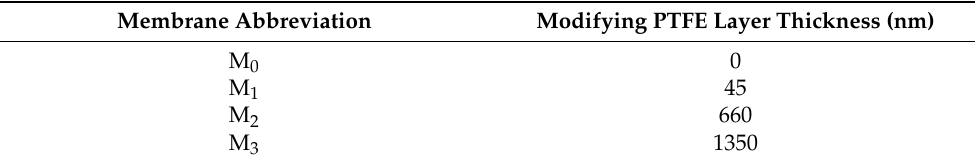
Table 1. Membrane abbreviations depending on the thickness of the modifying PTFE layer. Membrane